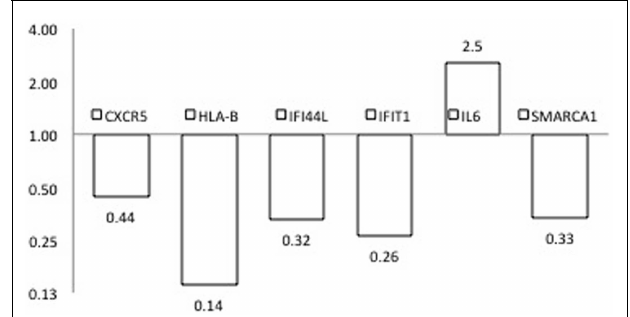
FIGURE 1 | Heat map showed, for all case/control sibling pairs, genes expression in red/green color based on ∆ C t values using Pearson’s correlation .The red indicated an increased expression with a ∆ C t value below the middle level and the green indicated a decreased expression with ∆ C t value above the middle level.